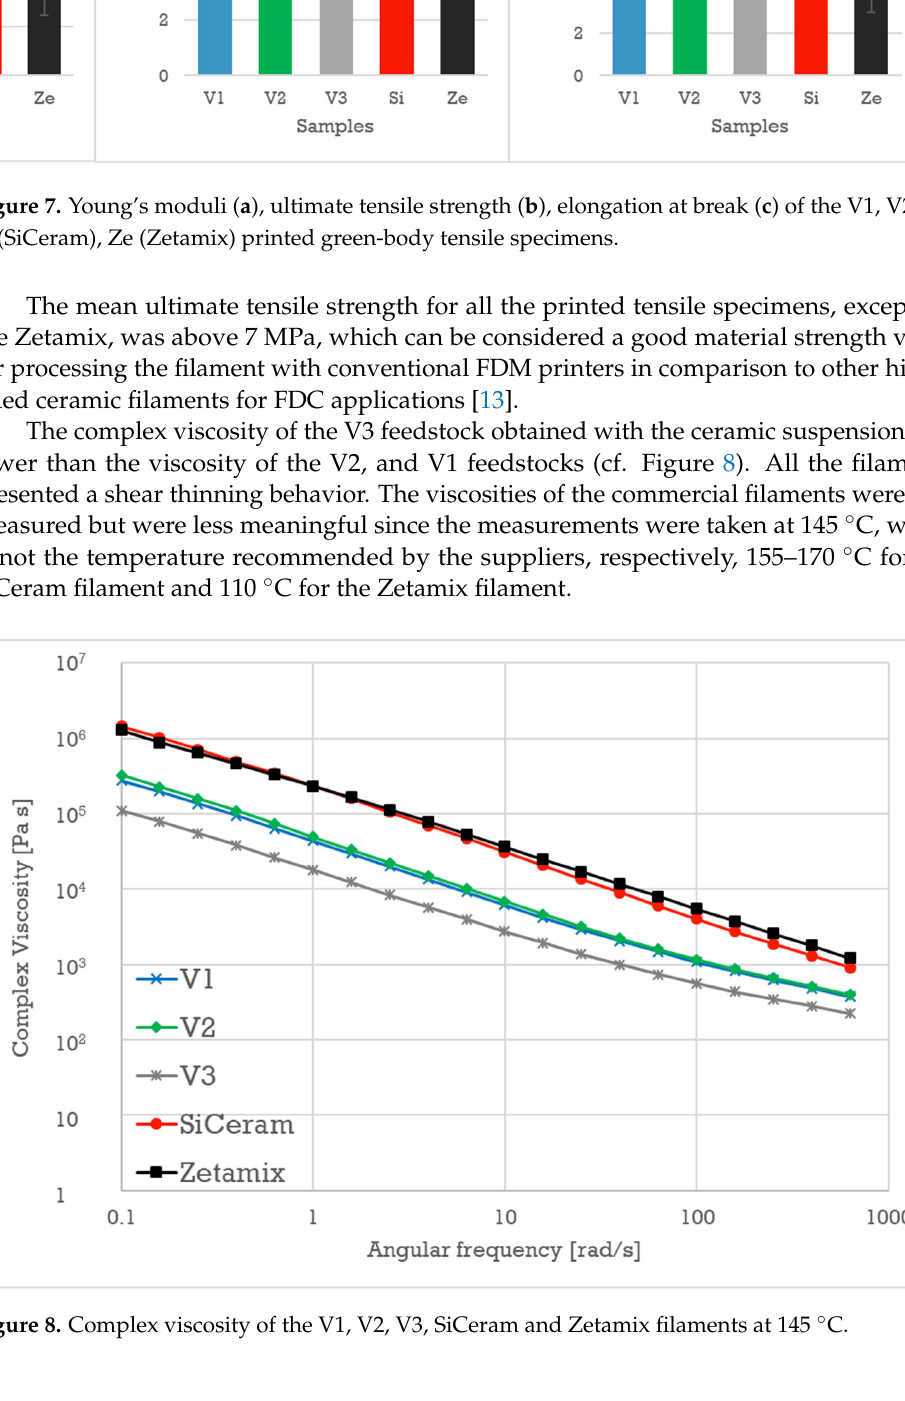
Figure 8. Complex viscosity of the V1, V2, V3, SiCeram and Zetamix filaments at 145